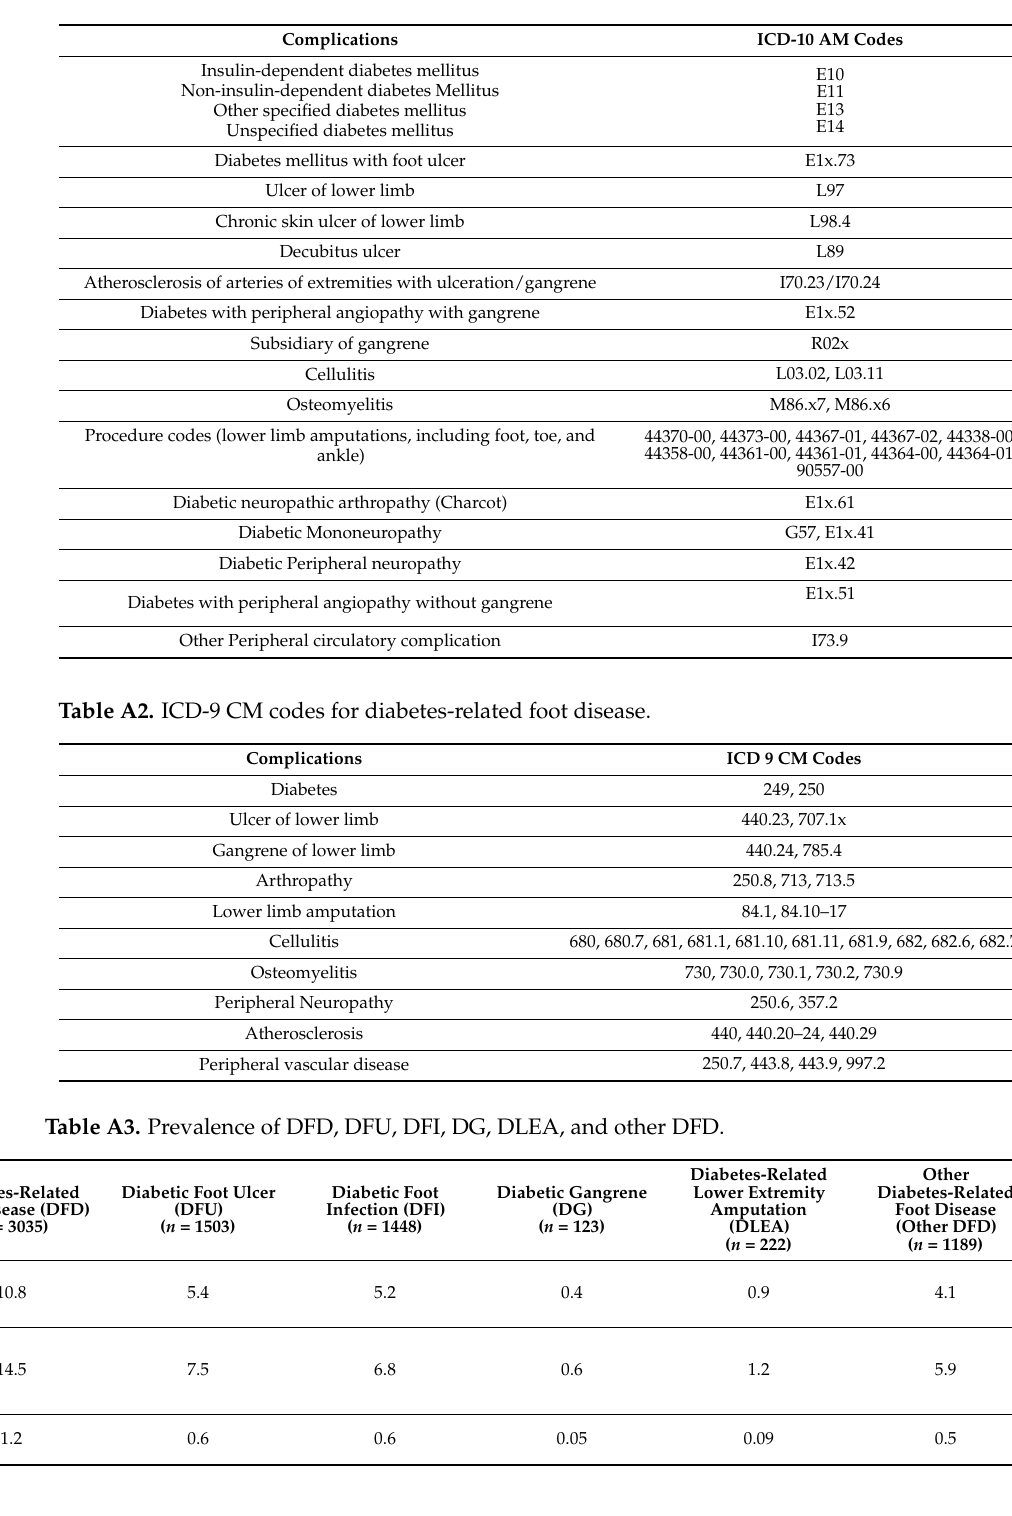
Table A1. ICD-10 AM codes for diabetes-related foot disease.